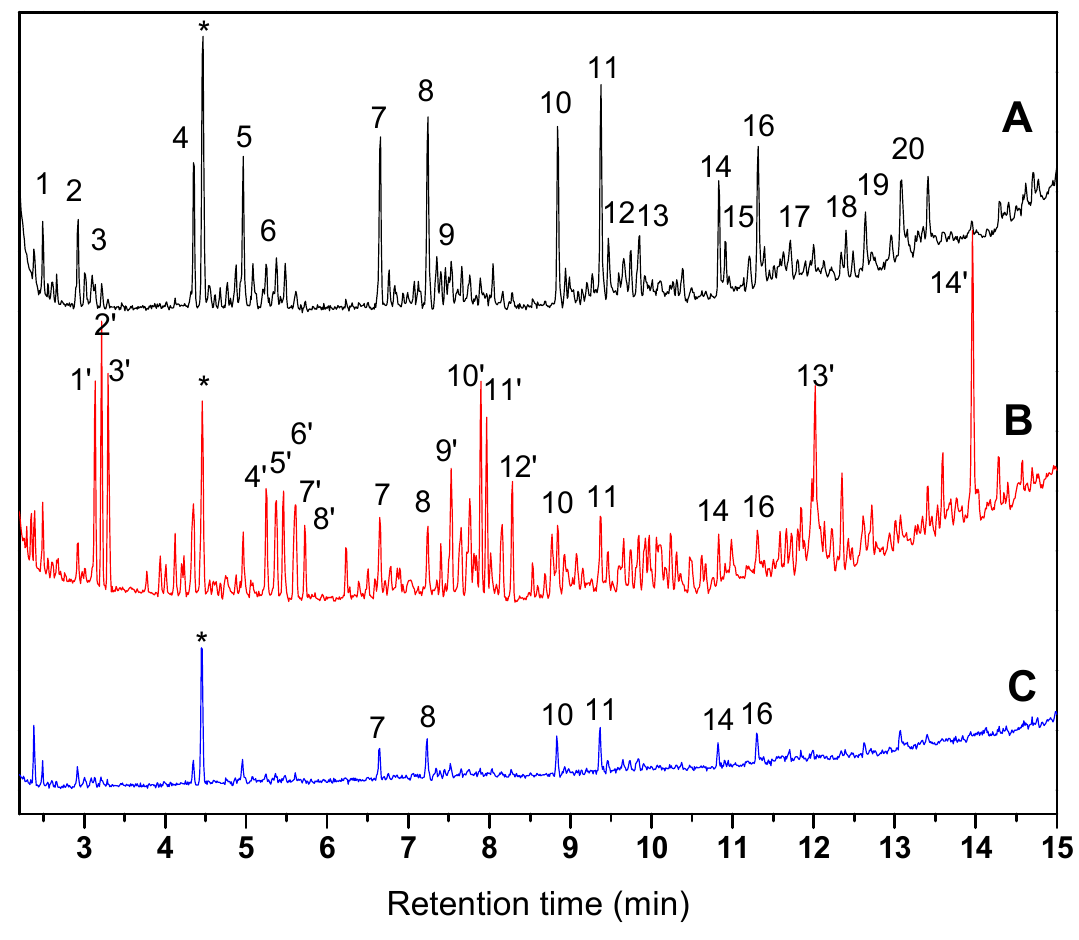
Figure 5. GC-MS chromatograms: ( A ) raw produced water; ( B ) water treated by photocatalysis with ZnO for 6 h; ( C ) water treated by photocatalysis with ZnO for 12 h. The solvent peak is denoted by an asterisk. Table 5. Assignment of chromatographic peaks.